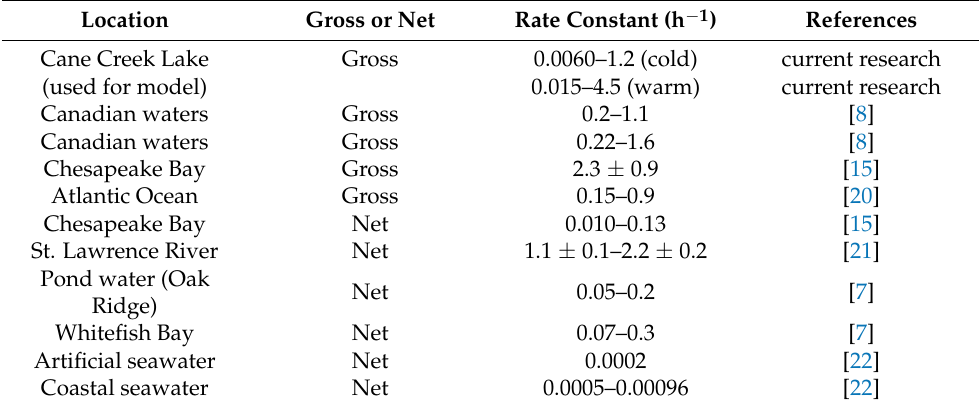
Table 3. Comparison of the modeled rate constants with the published rate constants.